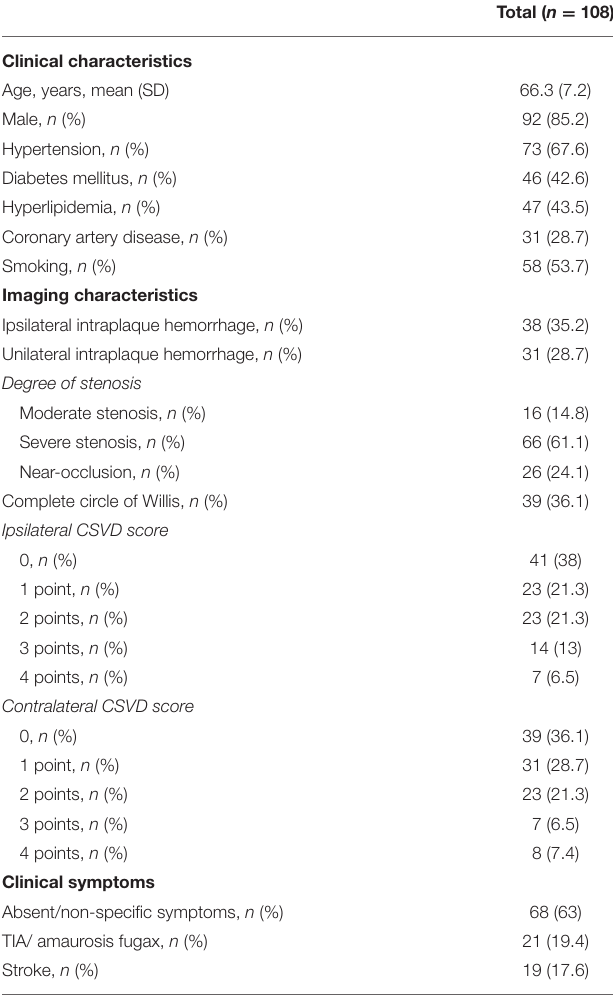
TABLE 1 | Characteristics of the study